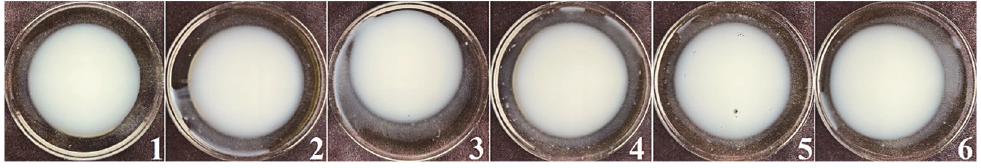
Figure 2. The nanoemulsion images obtained by dilution with ultrapure water. The numbers are given in order of nanoemulsions.